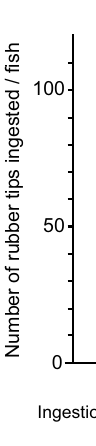
Figure 7. Active ingestion of rubber tips by goldfish. Goldfish ingested rubber tips in the absence of fish feed. The number of ingested rubber tips in the intestine was counted at dissection.